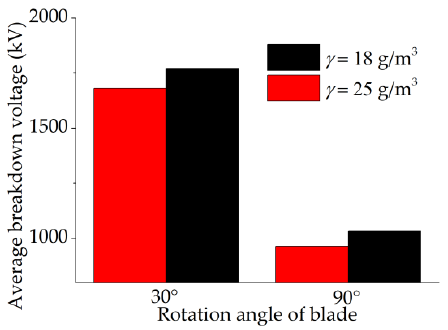
Figure 12. Average breakdown voltage with blade angles of 30° and 90°.